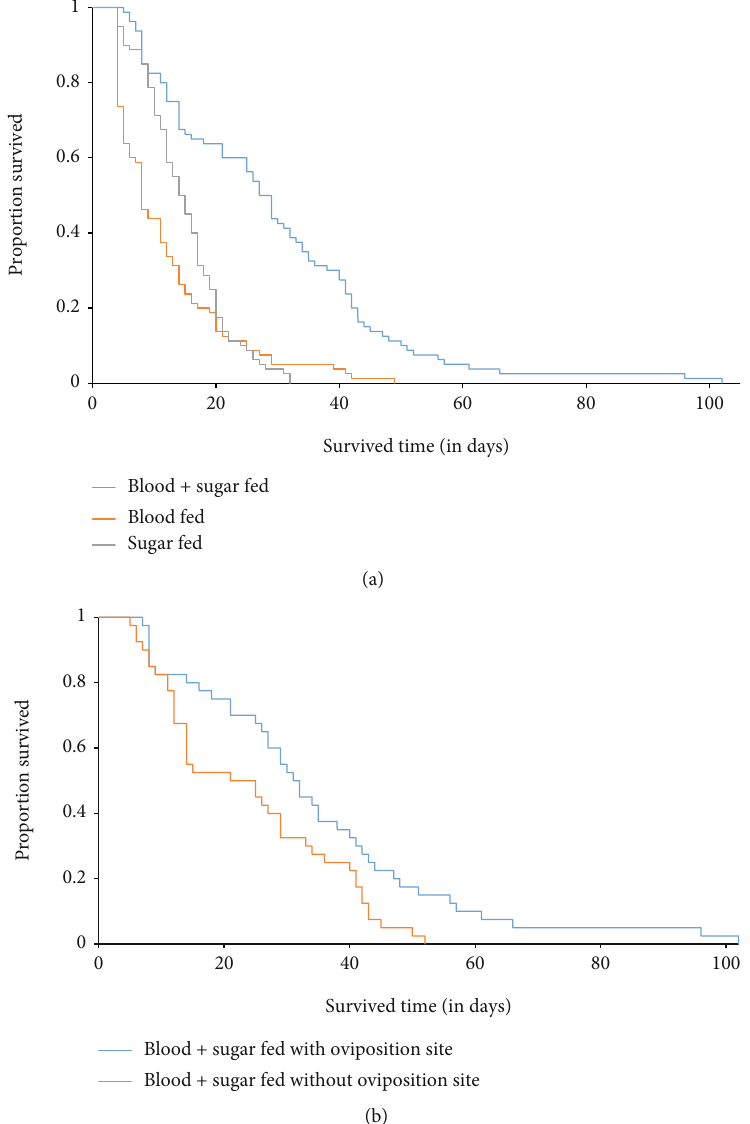
Figure 2: (a) Kaplan-Meier survival curve of adult An. gambiae s.s. fed on both blood and sugar, blood alone, and sugar alone provided and deprived oviposition sites. (b) Kaplan-Meier survival curve of adult An. gambiae s.s. fed on both blood and sugar provided and deprived oviposition